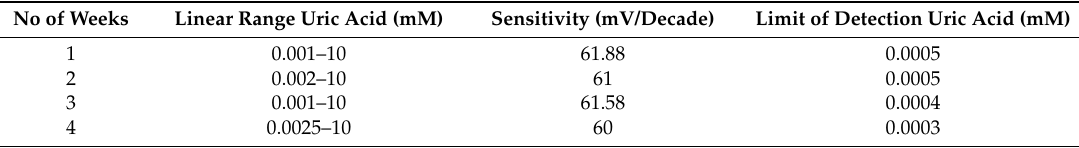
Table 2. The recovery method results for the analytical reliability of uric acid biosensor.